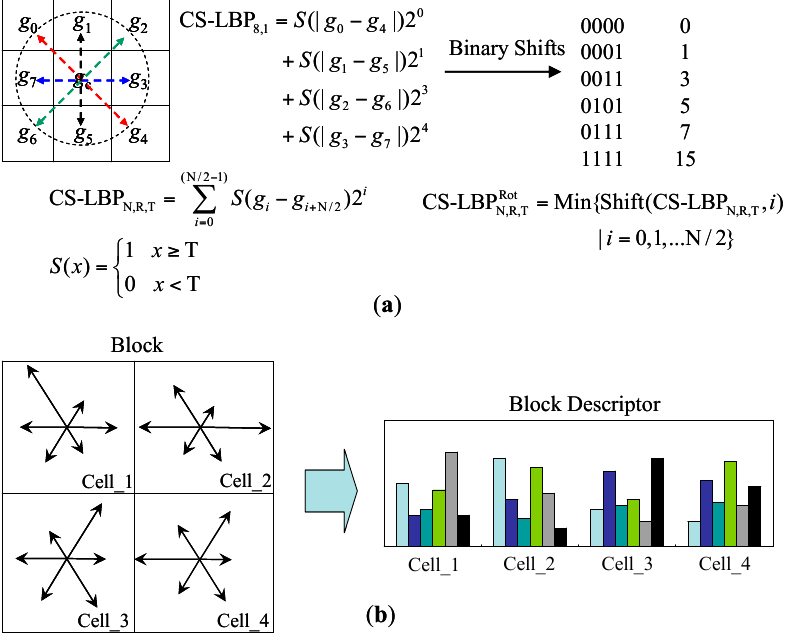
Figure 7. ( a ) Rotation-invariant CS-LBP descriptor; ( b ) Rotation-invariant CS-LBP block descriptor.